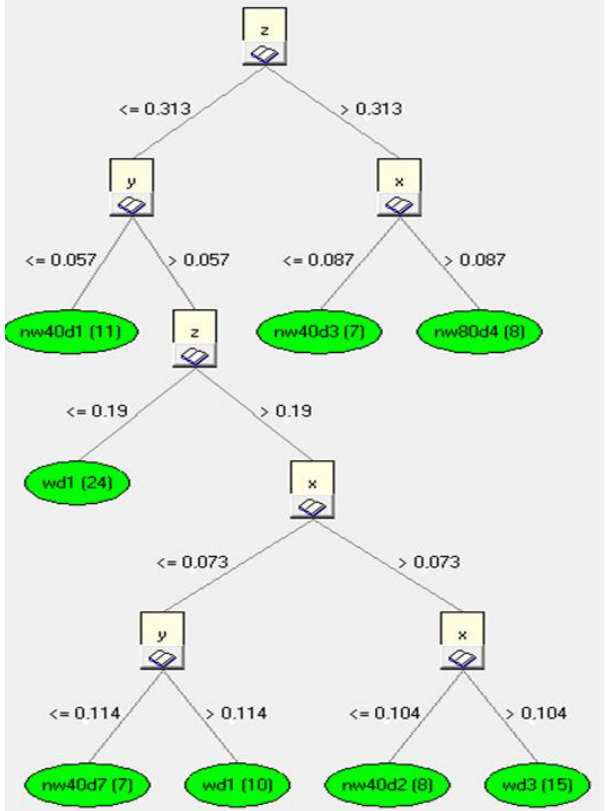
Figure 15. Induction tree of the analyzed z- axis data.